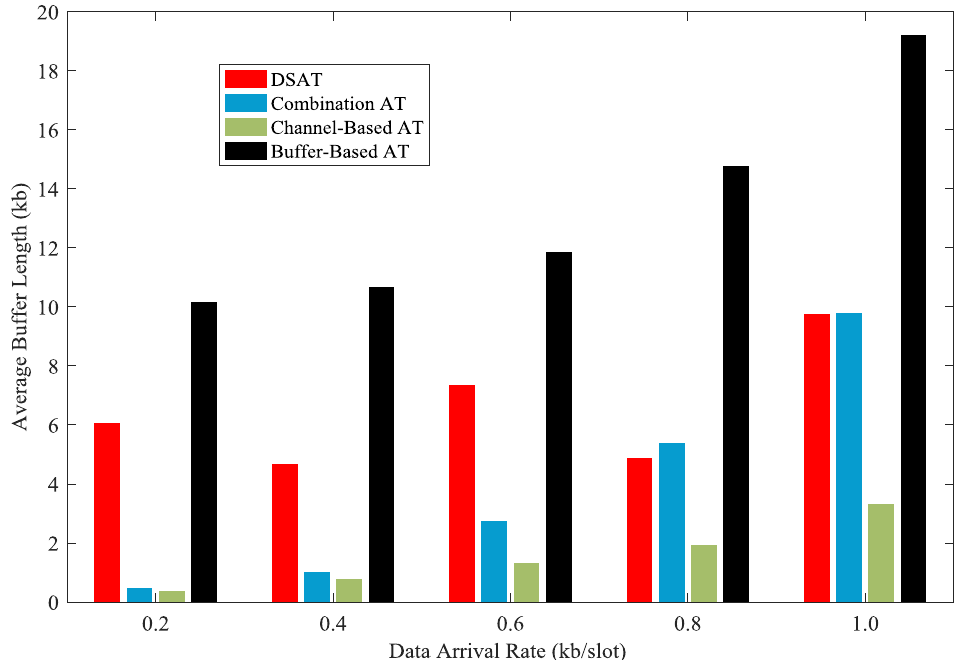
Figure 26. Average buffer length for comparative strategies (Data 2).